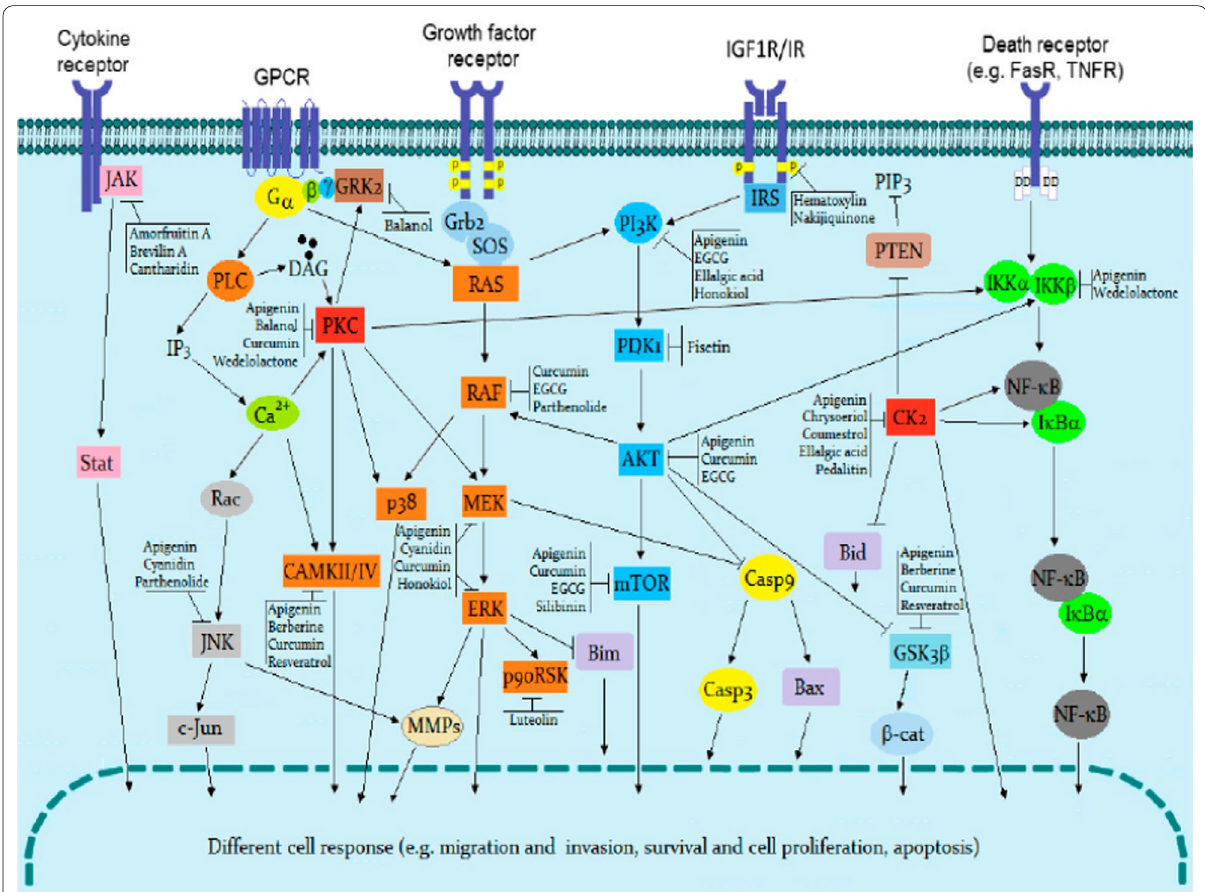
Fig. 3 Inhibition of signal transduction pathways by natural compounds